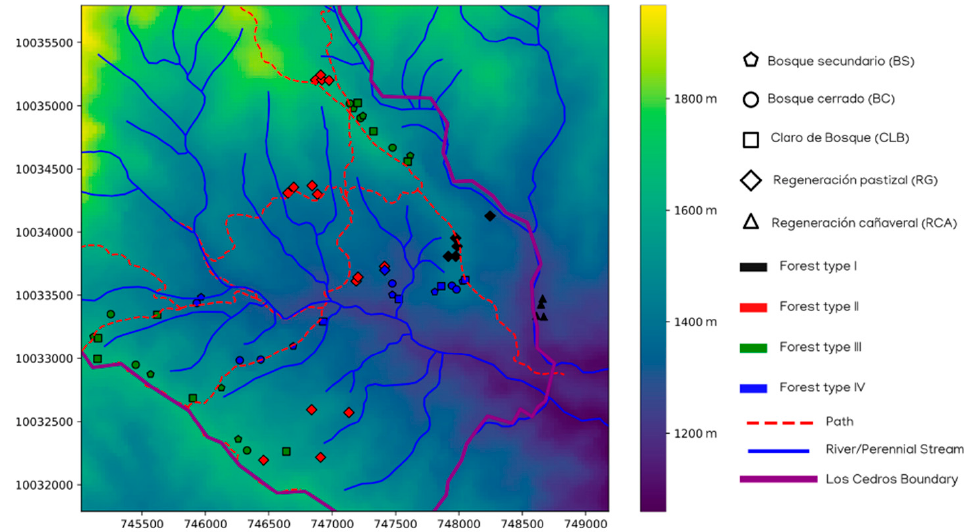
Figure 6. Map of sites with land-use history and current ecological state (“forest type”). X and Y coordinates are Universal Transverse Mercator (zone 17S) coordinates in meters.